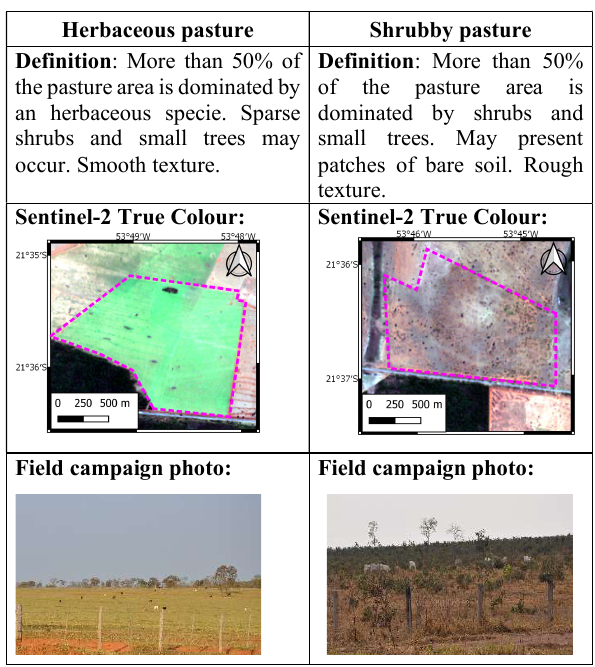
Table 1: The two pasture classes analysed in this study: class definitions, examples of remote sensing images (Sentinel-2 true colour composition of the dry season) and also photographs taken on the field campaign.